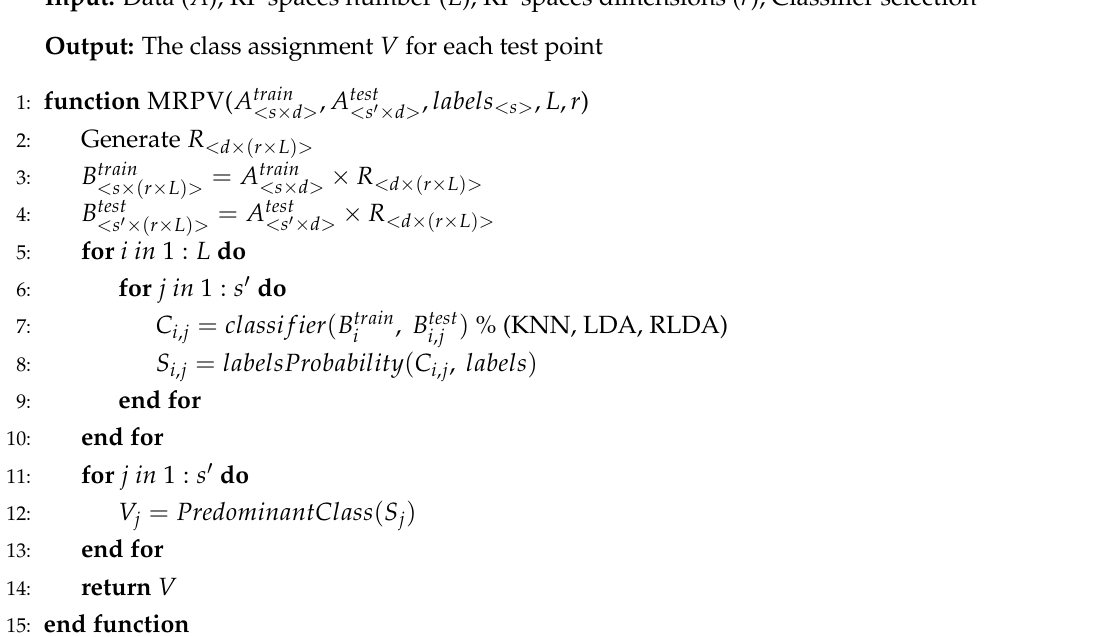
Algorithm 1 MRPV Pseudocode